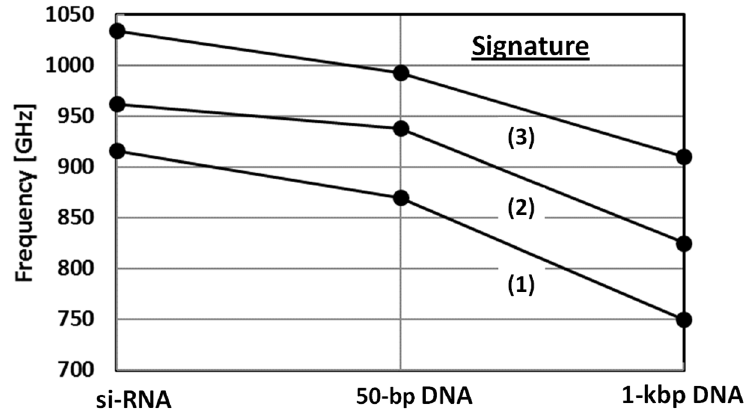
Figure 7. Center frequency of three prominent signatures vs. sample type. Note that the horizontal axis is not proportionate.